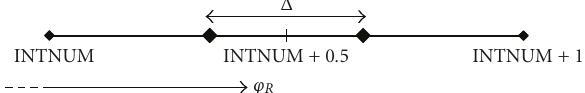
Figure 2: Segment on the unwrapped phase axis between two integer numbers [INTNUM,